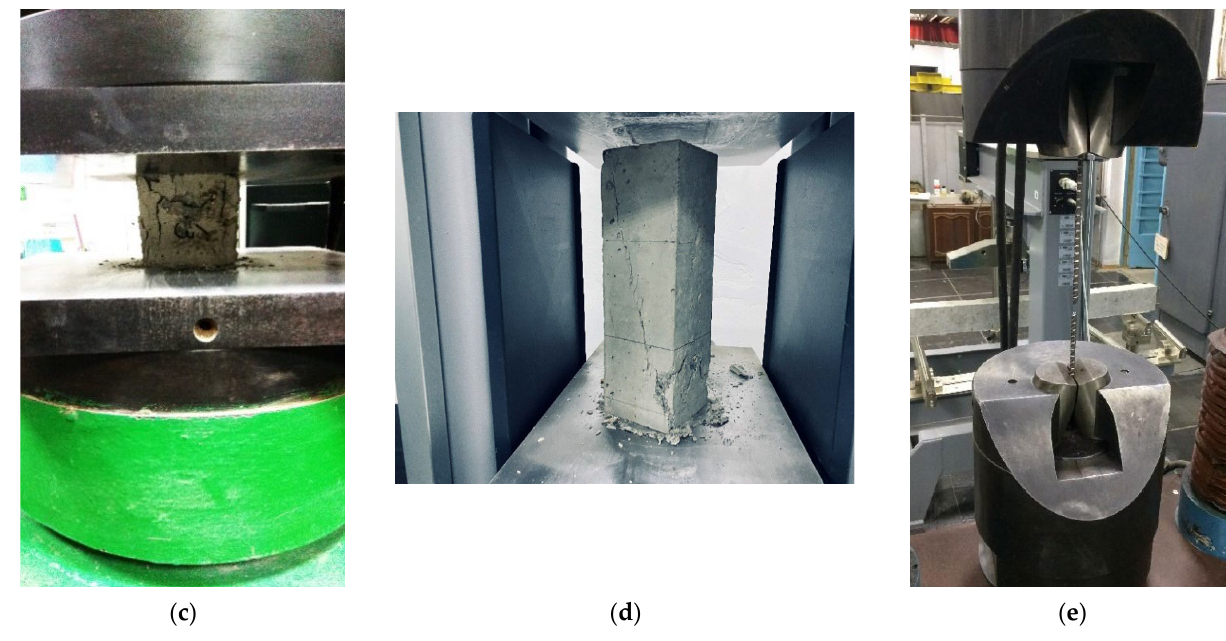
Figure 2. General view of the formwork with the reinforcement ( a ); general view of the test frame formwork after concreting ( b ); testing of the specimens: concrete cube ( c ), concrete prism ( d ), reinforcement steel bar ( e ). Table 1. Composition of concrete mixture.